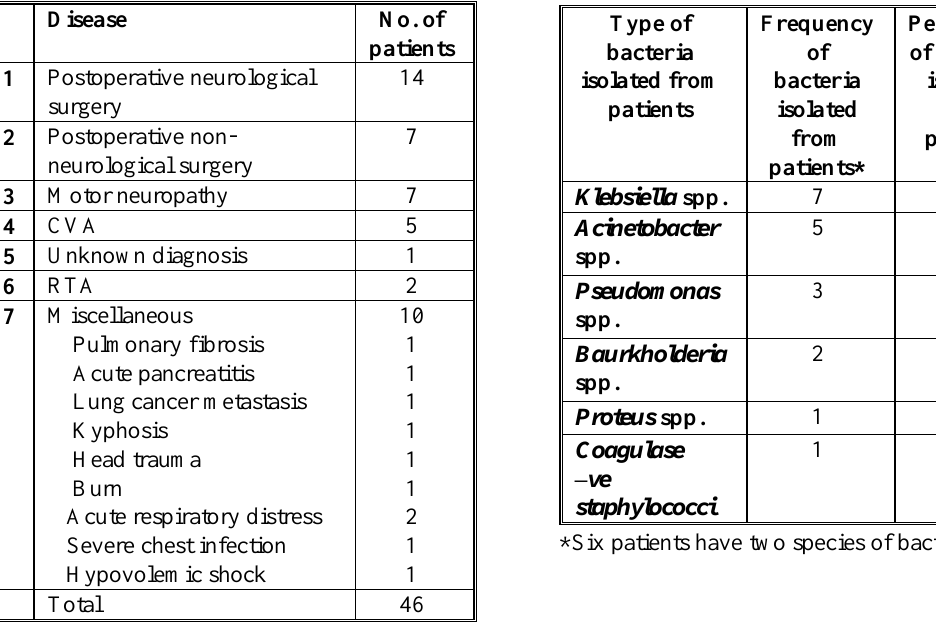
Table (3): Types and frequency of bacteria isolated from patients of the ICU.